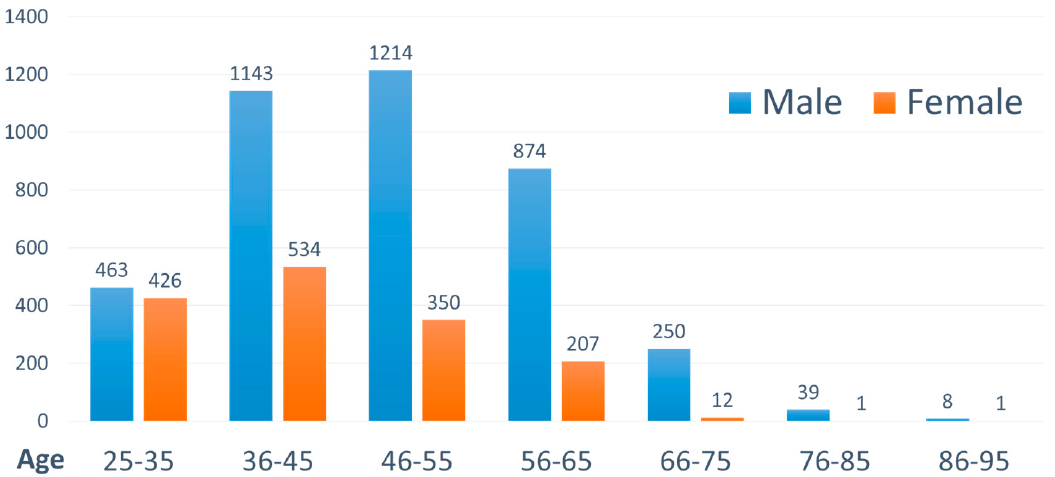
Figure 1. Age and sex distribution of traditional Chinese medicine physicians (TCMPs) in Taiwan in 2012.